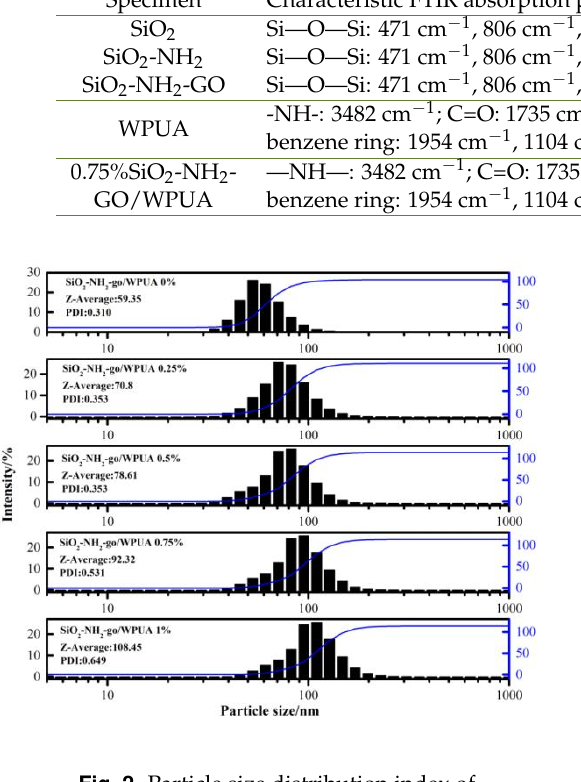
Fig. 4 is the mechanical properties curve of WPUA and SiO 2 -NH 2 -GO/WPUA films. It can be seen from Fig. 4 that the tensile strength increases with the increase of SiO 2 - NH 2 -GO content in WPUA. When the mass fraction of filler was 0.75%, the tensile strength of WPUA films